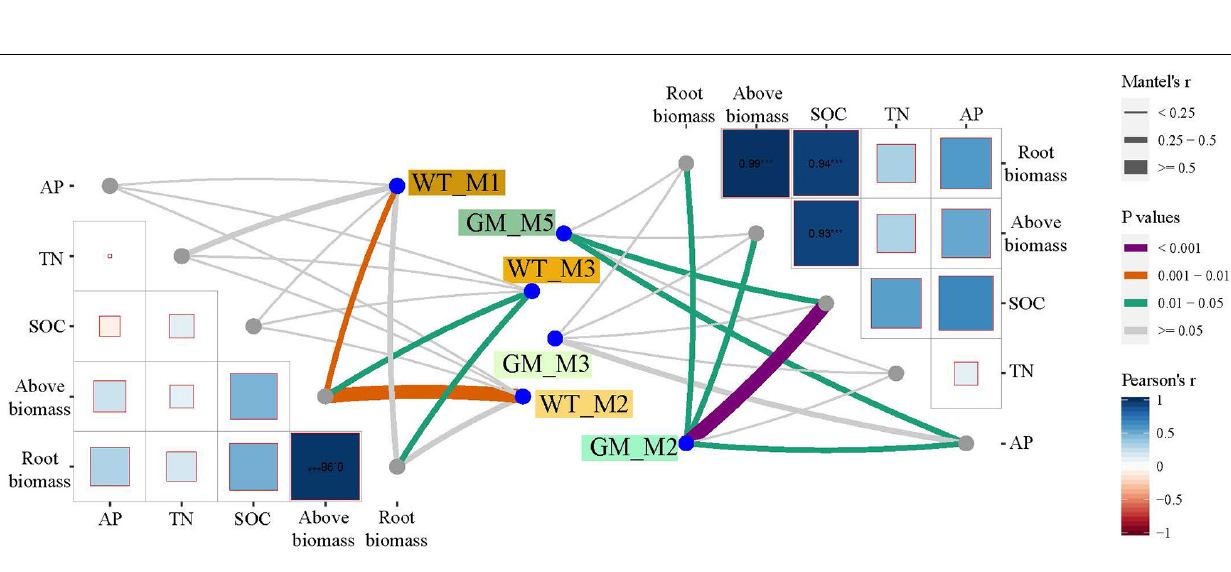
Frontiers in Microbiology |